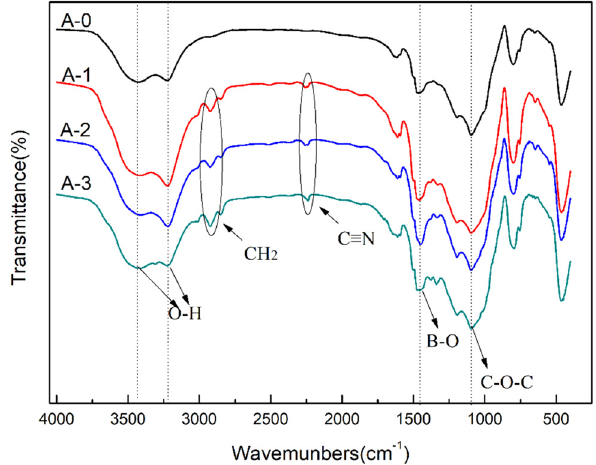
Figure 3: FTIR spectra of the